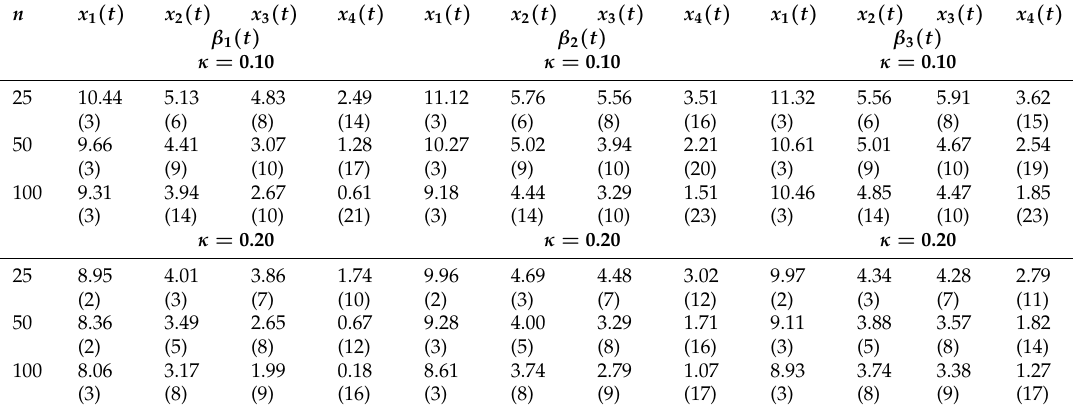
Table 4. The SMISE ( n ) under each simulation setting. The size of ζ ( x ( t )) is shown below each respective SMISE ( n ) in